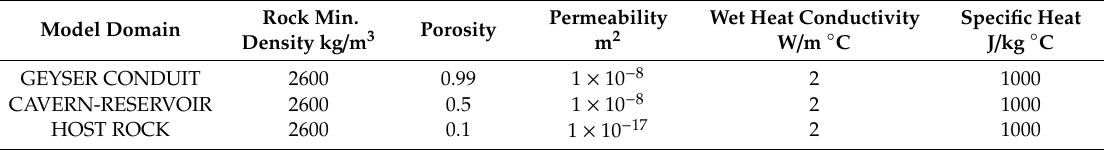
Figure 7. Cross-section of the Shaman geyser RZ-model showing the numerical grid, model zonation, and boundary conditions. Numbers are the names of selected model elements. Table 3. Material properties assigned in the model, linear relative permeabilities with zero residual saturations were assigned in all model domains.